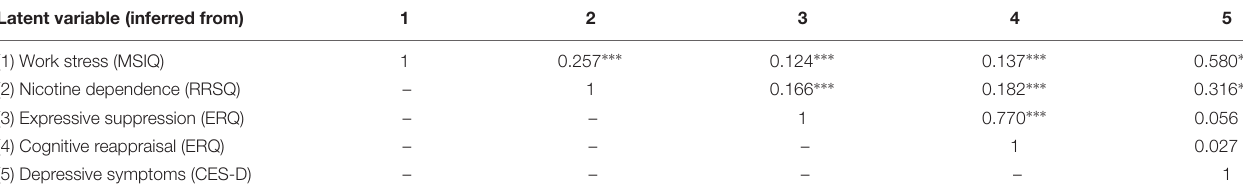
TABLE 3 | Zero-order correlations among latent variables. Latent variable (inferred from)